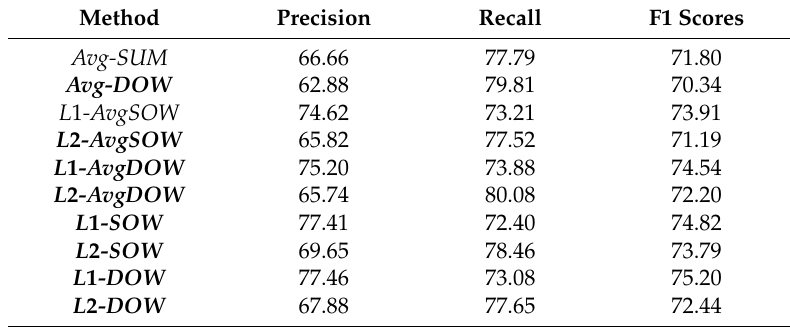
Table 5. Results of normalized representation of sentence vectors on SemEval-2016 dataset.